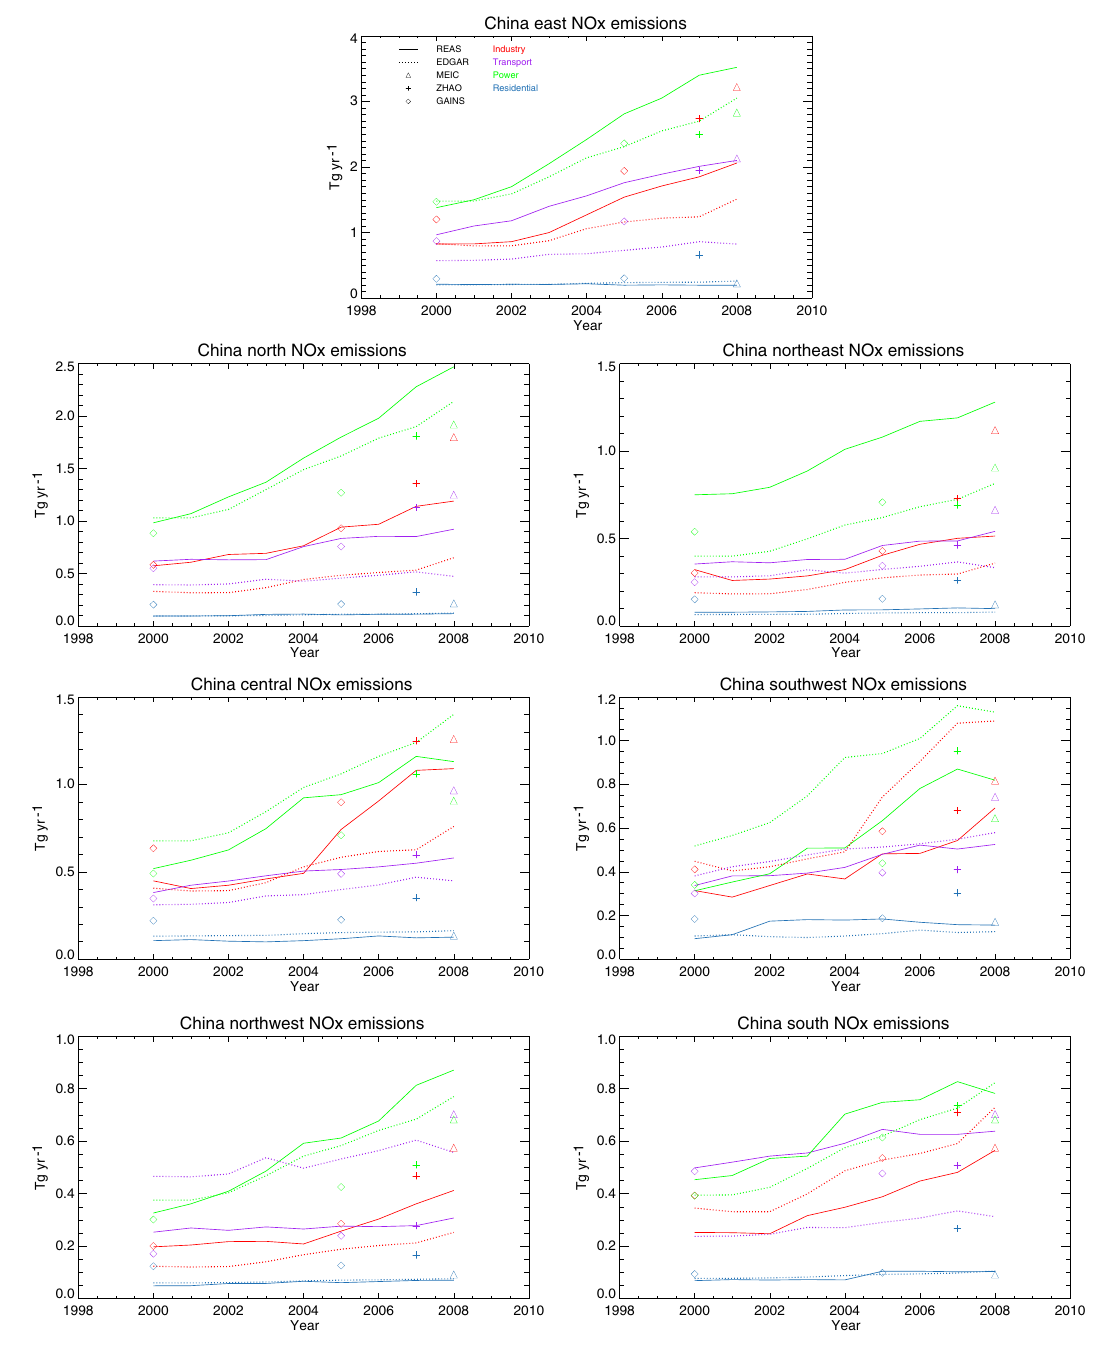
Figure 8. Regional total emissions for NO x for four different source sectors (industry, transport, power, and residential) estimated by REAS, EDGAR, MEIC, ZHAO, and GAINS between 2000 and